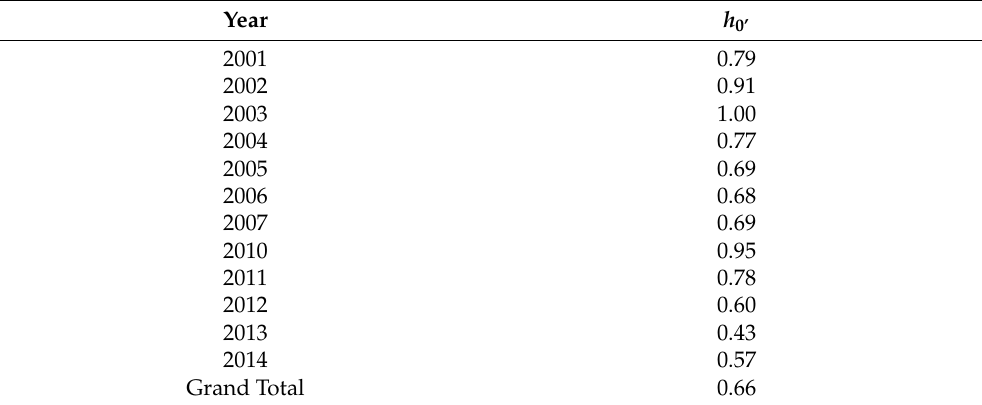
Table 2. Racial diversity of isolates of P. infestans characterized by normalized Shannon diversity index ( h 0’ ) in potato breeding fields in Estonia during 2001–2007 and